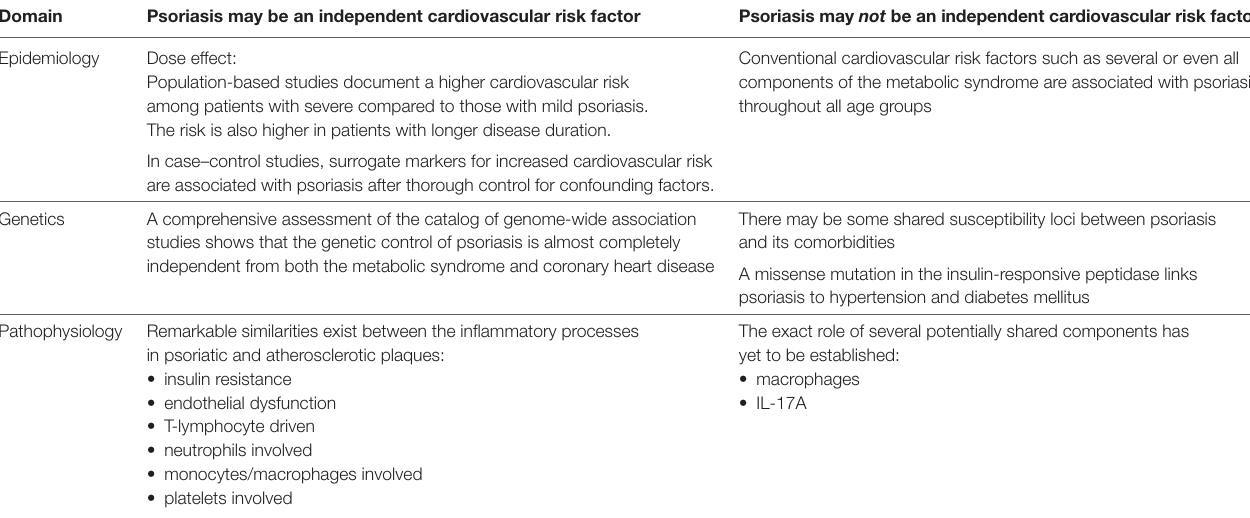
Table 2 | Synopsis of arguments in favor or against the hypothesis of psoriasis representing an independent cardiovascular risk factor.